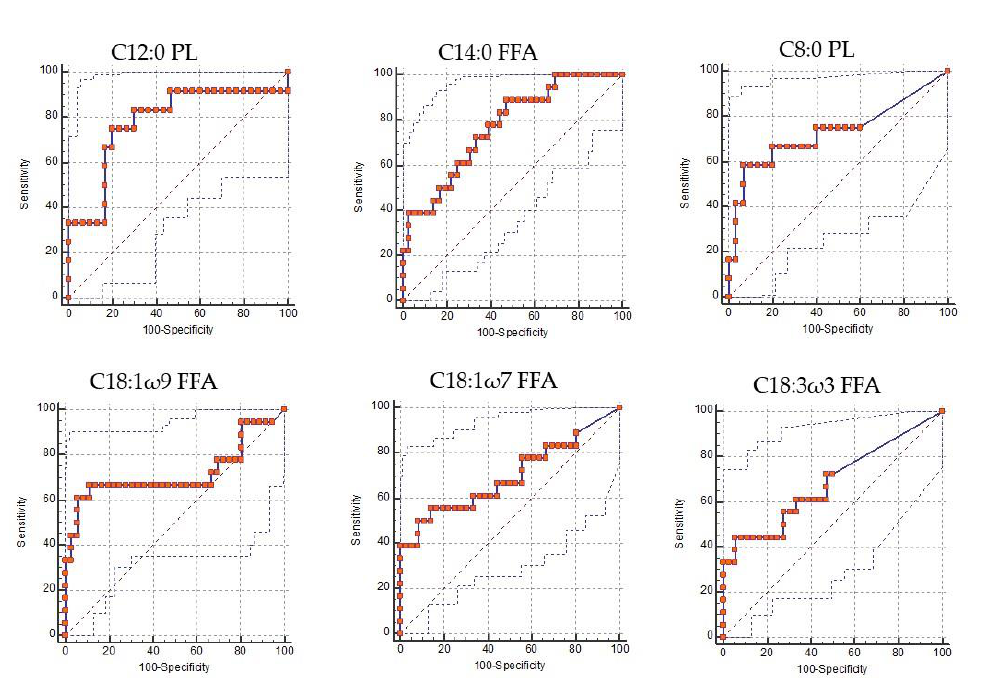
Table 4. Results of the ROC analysis of the predictive fatty acids (FAs) on the basis of NEFA values (greater than 0.56 mEq/L).